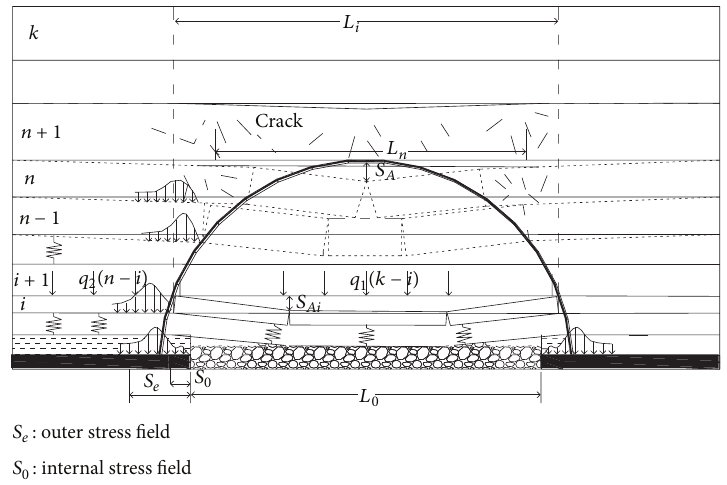
Figure 2: The stress model of out-arch strata.